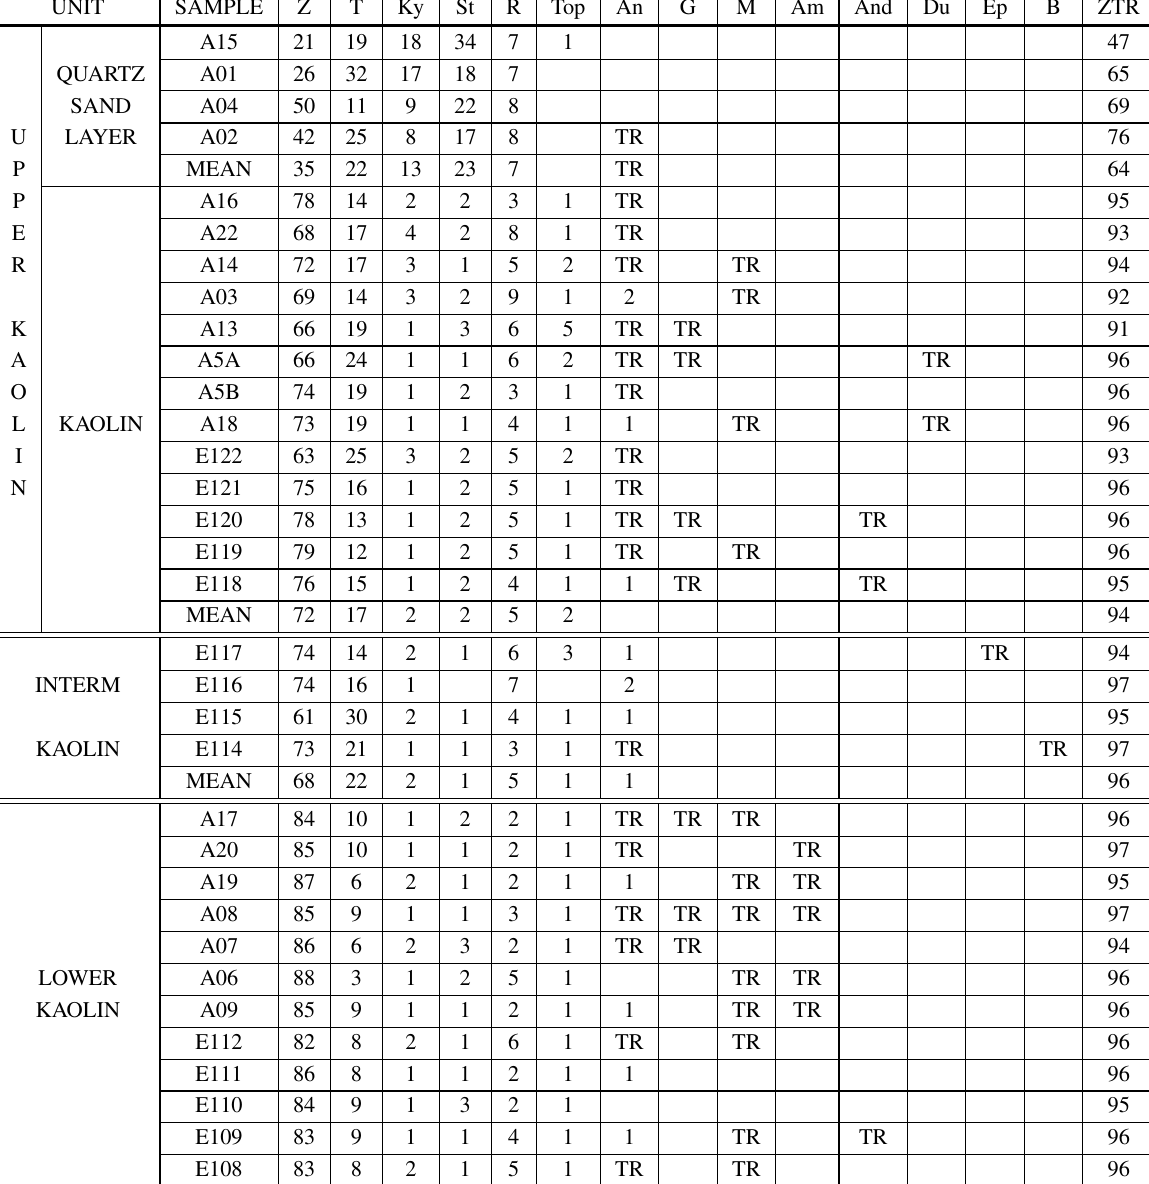
Percent composition of heavy minerals in the 63–250 micron size fraction from kaolin units in IRCC quarry. TR = trace ( < 1%), ZTR = Zircon + Tourmaline + Rutile, Tra = Transparent, Z = Zircon, T = Tourmaline, Ky = kyanite, St = staurolite, R = Rutile, Top = Topaz, An = Anatasio, G = Garnet, M = Monazite, Am = Amphibole, And = Andalusite, Du = Dumortierite, Ep = Epidote and B =